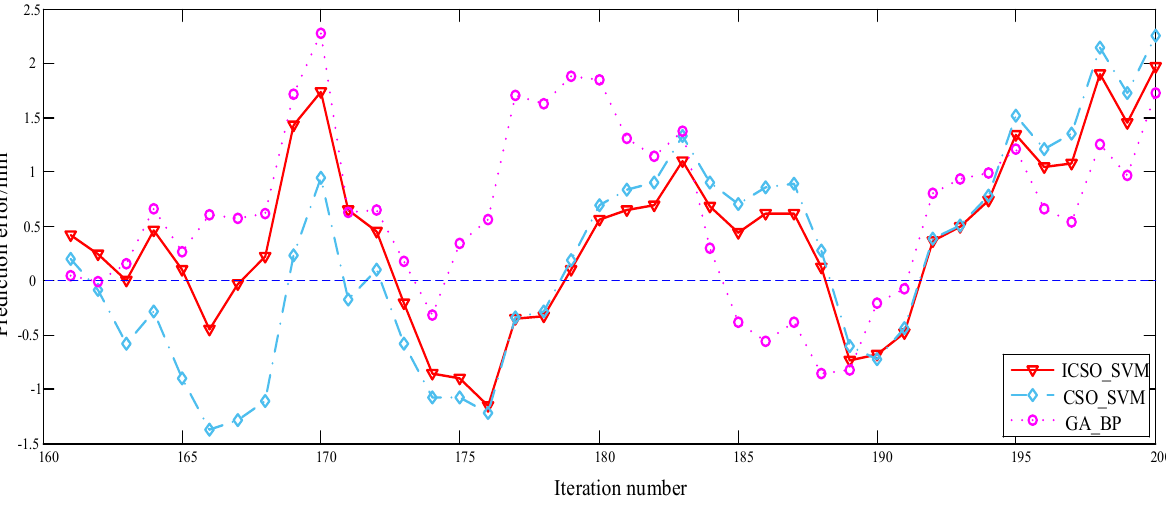
Figure 14. Prediction error curve of horizontal displacement of dam test samples. SVM model is [ − 1.156, 1.966], and the length of the error fluctuation interval is 3.122 mm. The prediction error fluctuation range of the CSO-SVM model is [ − 1.379, 2.248], and the length of the error fluctuation interval is 3.627 mm. The prediction error fluctuation range of the GA-BP model is [ − 0.853, 2.278], and the length of the error fluctuation interval is 3.131 mm. Compared with the CSO-SVM and GA-BP models, the error fluctuation range of model has a smaller fluctuation range around 0